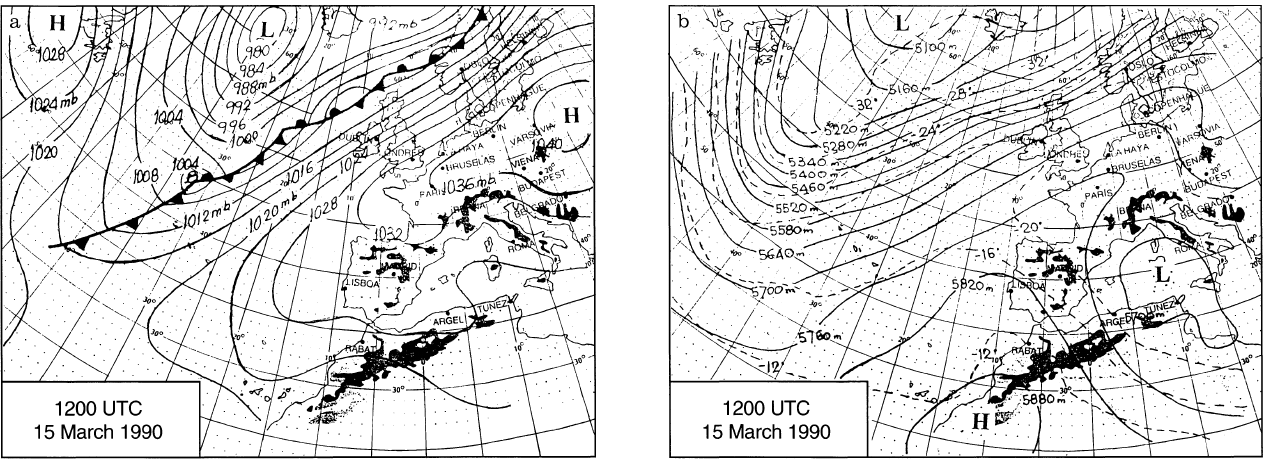
Fig. 2a,b. Synoptic situation at 1200 UTC on 15 March 1990. a Surface analysis (pressure contours every 4 mb); b 500 hPa analysis (height contours, every 60 m, continuous lines ; temperature contours, every 4 (cid:14) C, dashed lines